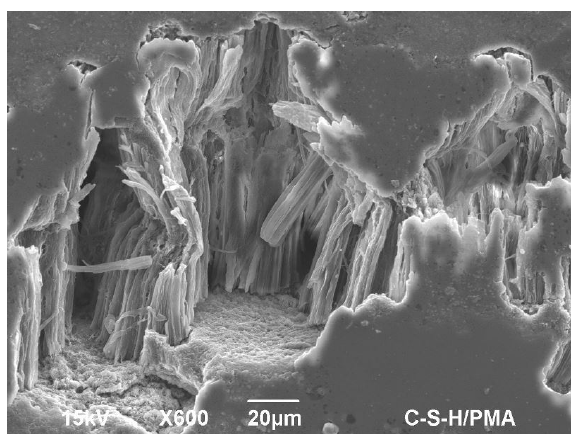
Figure 11. C-S-H/PMA SEM micrograph showing morphology of the microstructure.